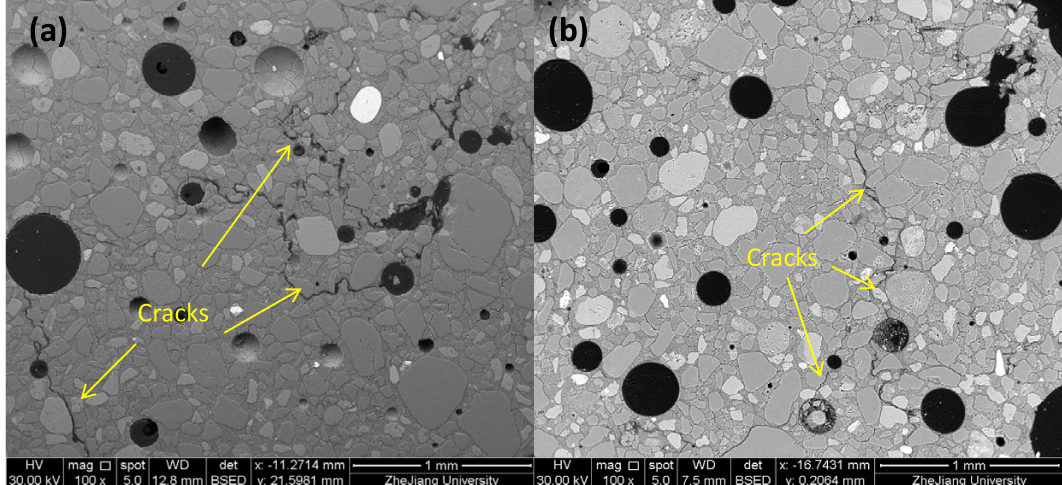
Figure 8. Typical SEM/BSE pictures of ( a ) MKG-4 and ( b ) MKG-5 specimens after F-T